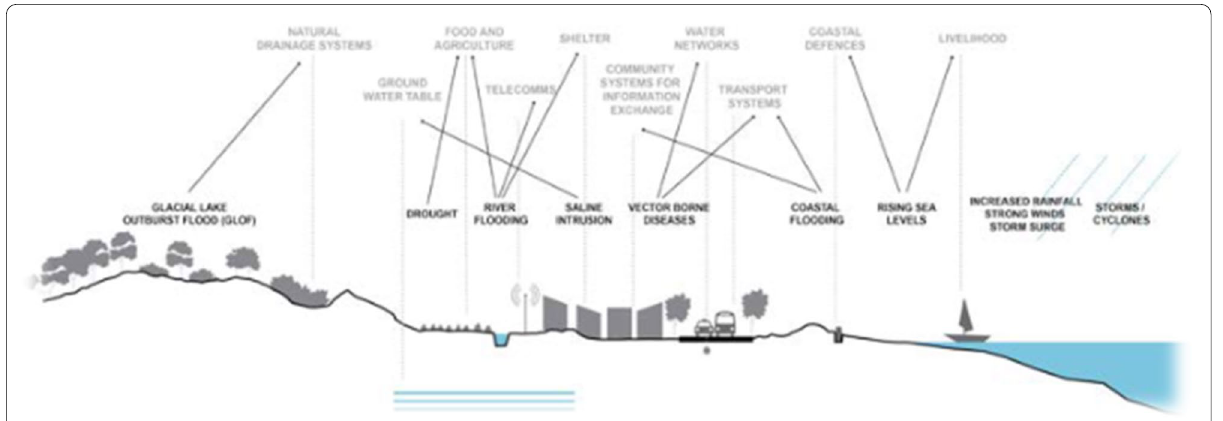
Fig. 5 Direct and indirect effects of climate change on urban